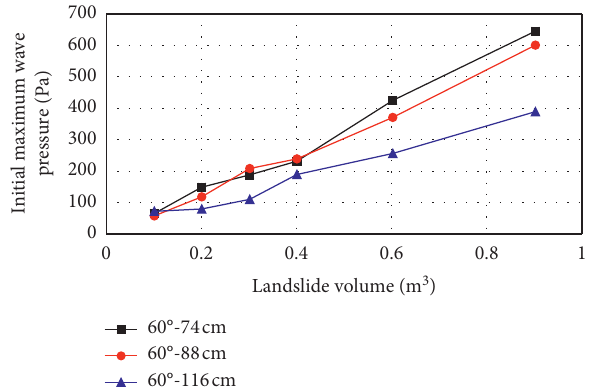
Figure 16: Variation of initial maximum wave pressure with landslide volume under different slope angles (at